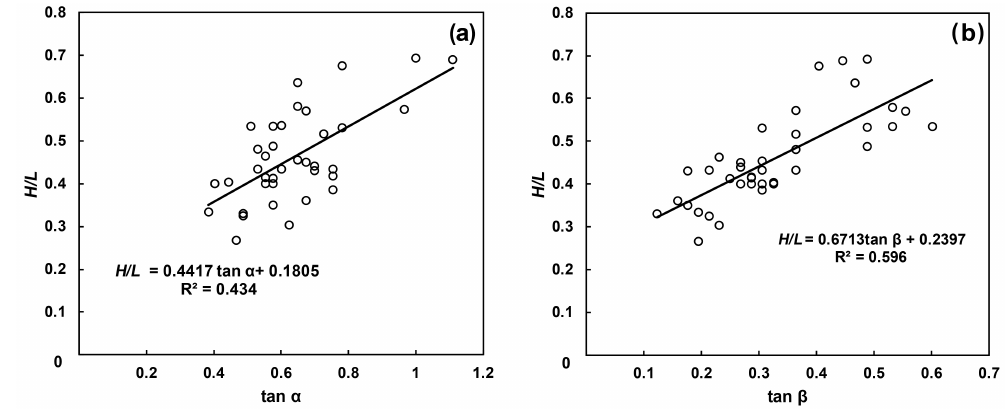
Figure 5. (a) Relationship between reach angle ( H/L ) and slope angle (tan α) ; (b) relationship between H/L and the channel gradient (tan β) of the rock avalanches.